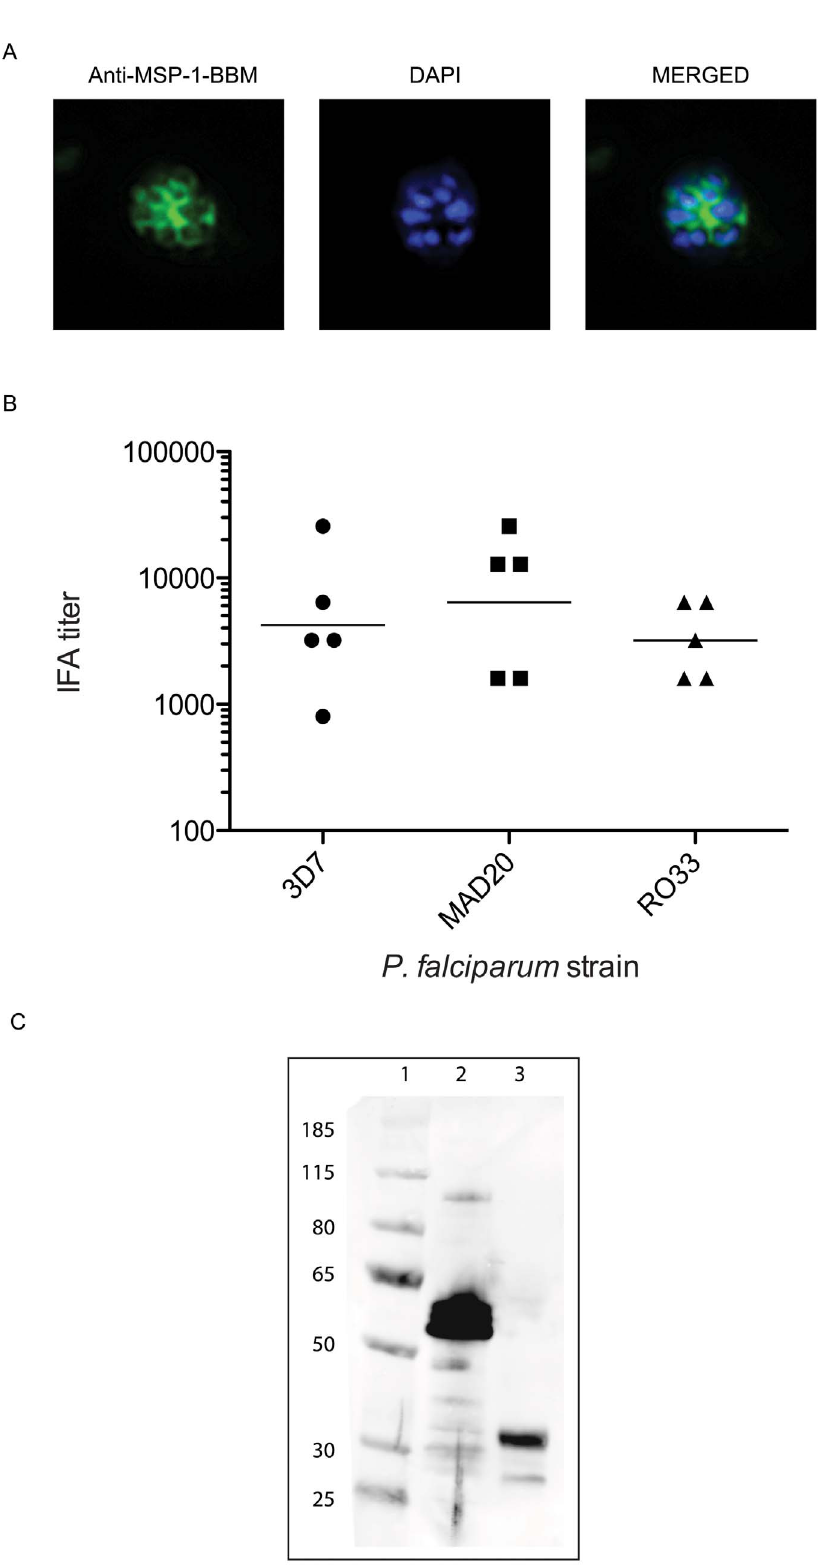
Figure 4. Indirect immunofluorescence assay (IFA) of sera from MSP-1-BBM immunized mice against three strains of P.falciparum . A. Representative micrograph of IFA assay with sera from MSP-1-BBM immunized mice. DAPI staining of parasite nuclei is shown in blue and fluorescence from the FITC-conjugated secondary antibody is shown in green. B. IFA titers of sera from mice immunized with MSP-1-BBM protein. Sera were tested by IFA against the 3D7 (K1 serotype), MAD20 and RO33 strains of P. falciparum , as described in materials and methods. IFA endpoint data is shown on a log 10 scale on the Y axis. Each symbol represents the serum reactivity for an individual animal, with the geometric mean of Ab